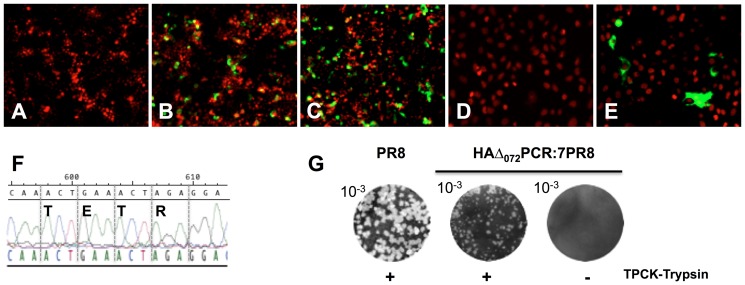
Identification of virus reassortants obtained using Flu PCR amplicons.Viruses recovered by reverse genetics were used to infect MDCK cells at a MOI of 0.001. At 36 hpi, cells were fixed with 4% Paraformaldehyde in PBS solution (Santa Cruz) and viral antigen detected by IFA using subtype specific monoclonal antibodies and FITC-labeled antimouse antibodies (green). Counterstaining was performed with propidium iodide (red). A) mAb 3B2 specific for the HA H1N1pdm virus has no reaction with the HA of PR8 strain (only cell nuclei can be seen in red reacting with propidium iodide) (X10). B) and C) Positive viral antigen green signal detected using mAb 3B2 in cells infected with either the H1N1pdmutr:6PR8 or H1N1pdm:6PR8 viruses, respectively (X10). D) mAb DPJY01 specific to H5N1 virus has no reaction with PR8-infected cells (X20). E) Positive reaction of mAb DPJY01 cells infected with H5Δ072N1:6PR8 (X20). F) Sequence of HA cleavage site of H5Δ072N1:6PR8 virus indicates the presence of a low pathogenic pattern (TETR), which was created by overlapping PCR as indicated in the materials and methods and Fig. 3B. G) Plaque assay was performed as described in materials and methods. The PR8 and H5Δ072:7PR8 viruses form plaques in agarose plates in the presence of 1 µg/mL TPCK-Trypsin but not in its absence.